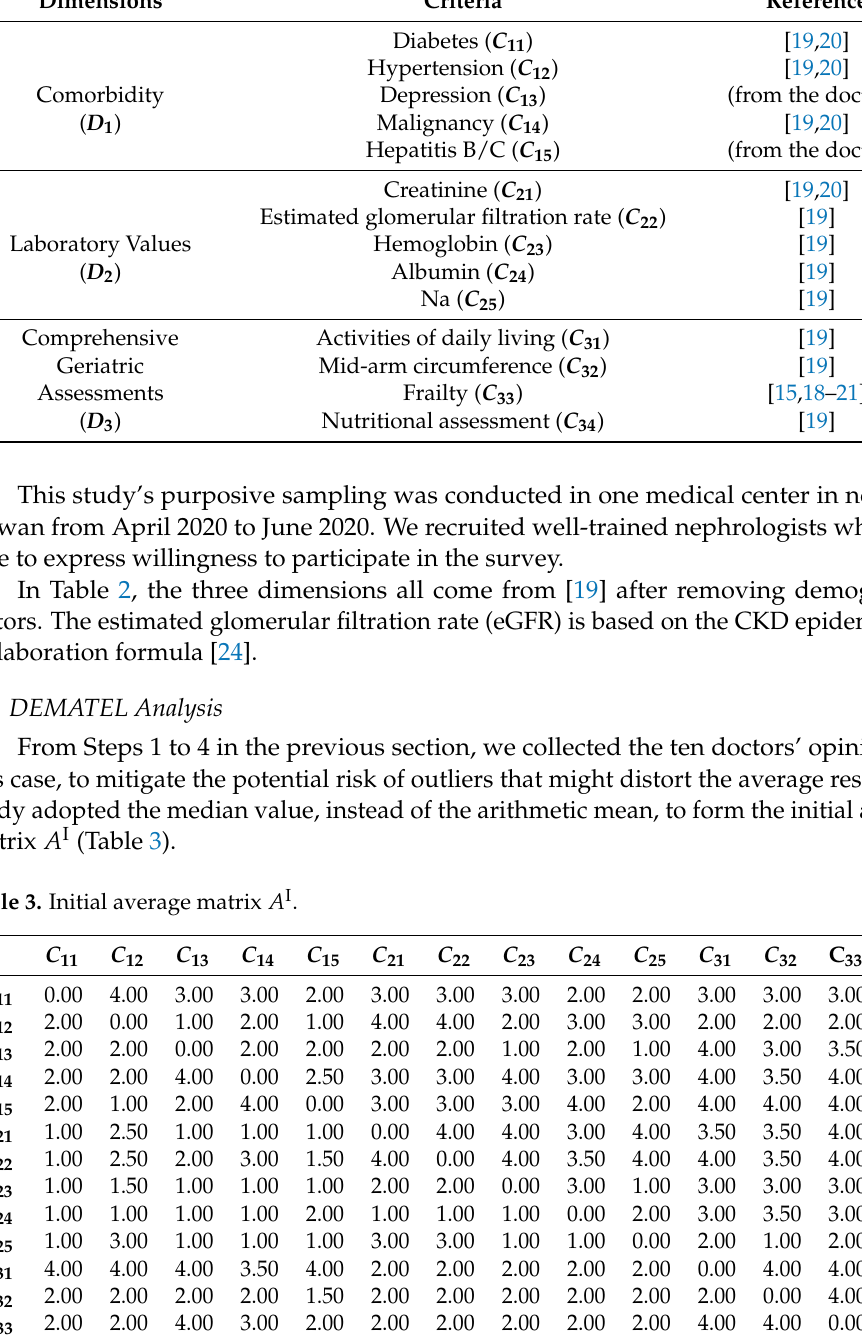
Table 2. The dimensions and criteria of the AKI (acute kidney injury) risk assessment decision model. Dimensions